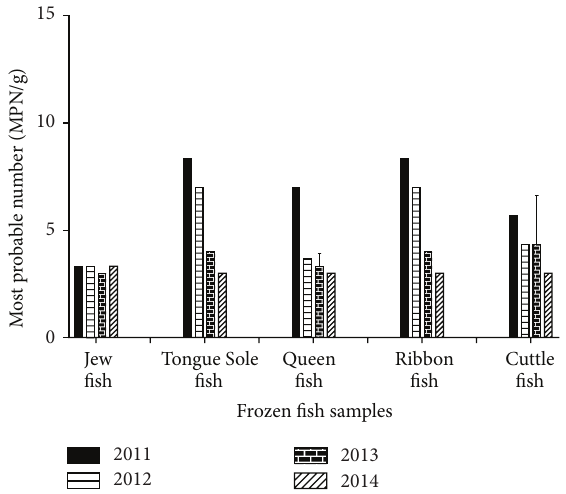
Figure 3: Total fecal coliforms count (MPN/g) of frozen fish samples. The data were representatives of the three independent experiments using triplicate samples and mean ± SD values were expressed.